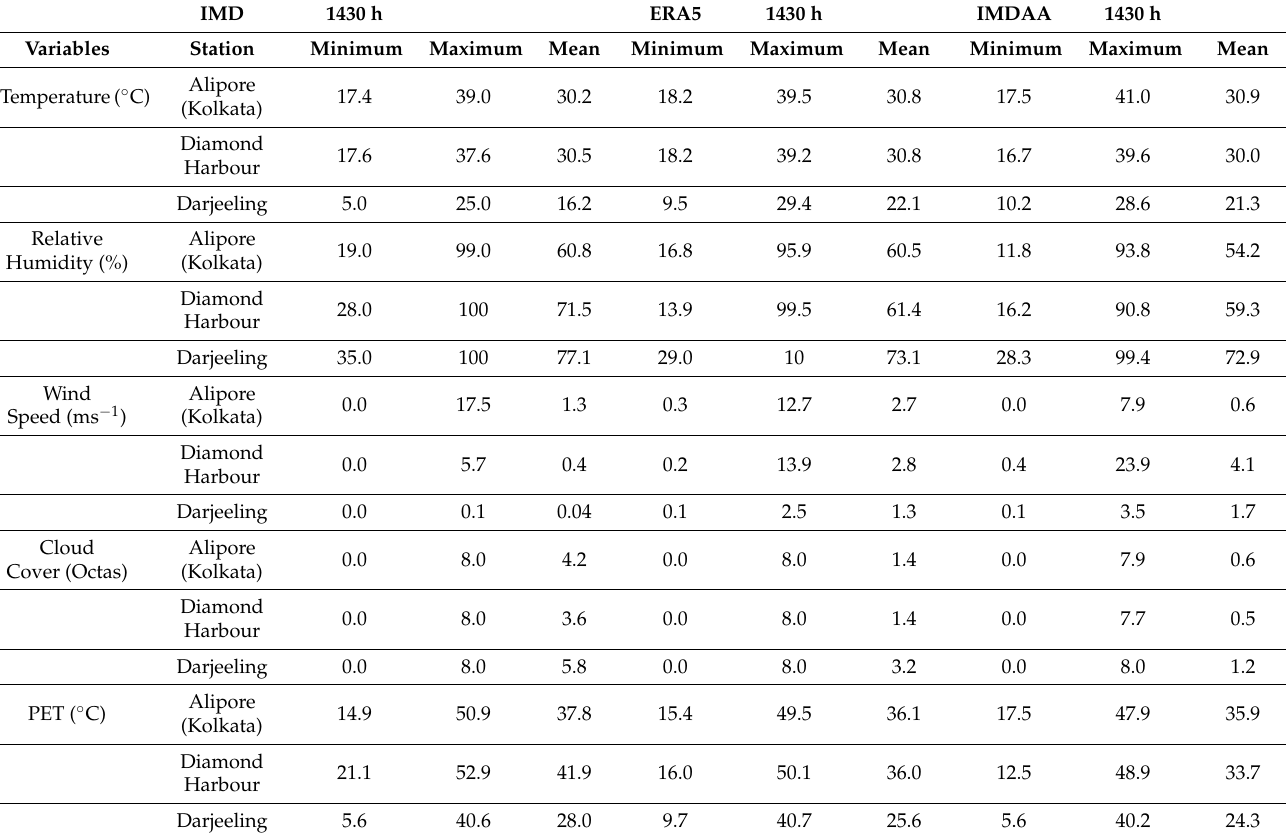
Table 4. Comparison of the descriptive statistics for temperature, relative humidity, wind speed, and cloud cover from ERA-5, IMDAA, and IMD. PET has been calculated by RayMan using daily data from 2020 to 2021 at 1430 h (IST). Three stations, namely Alipore (Kolkata), Diamond Harbour, and Darjeeling, have been chosen for this comparative